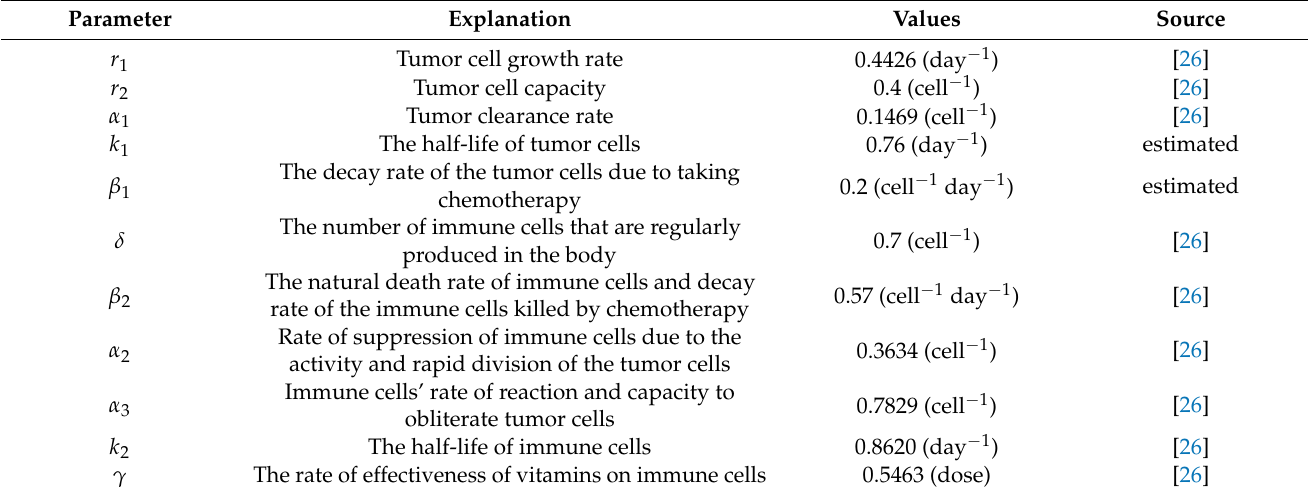
Table 1. Explanation of CICV system’s parameters.